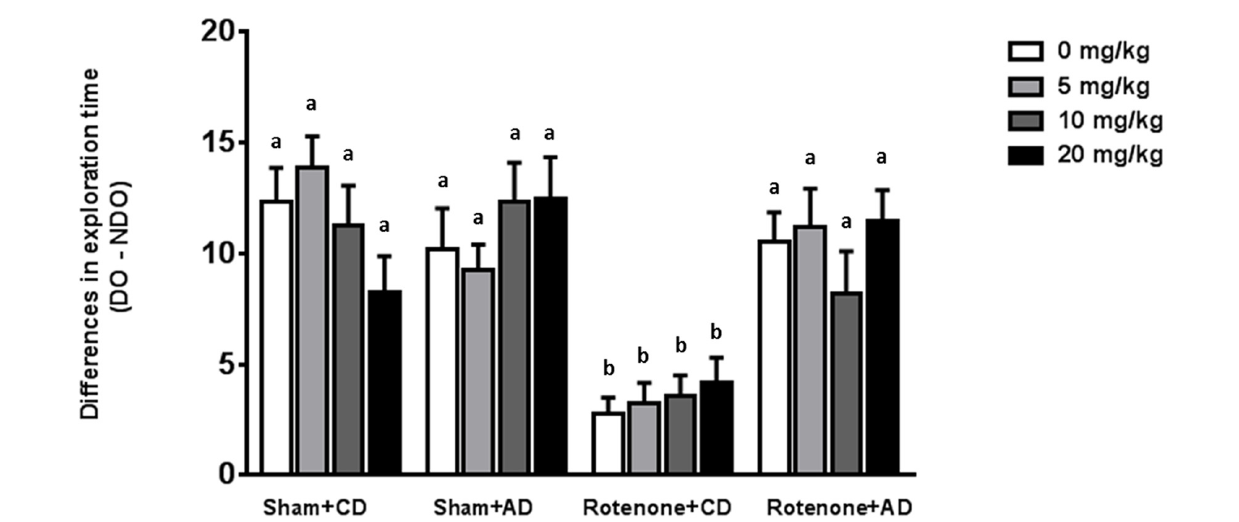
FIGURE 4 | Effects of the dietary intervention and different levodopa doses on spatial object recognition test. Sham-operated animals selectively re-explored the displace object (DO) as compared to the non-displaced object (NDO). Rotenone decreased animals’ ability to react to a spatial novelty. Rotenone-injected animals on the AD showed better spatial discrimination abilities compared to rotenone-injected animals on CD. Levodopa treatments did not affect spatial memory. Different letters indicate mean values were significantly different ( p <